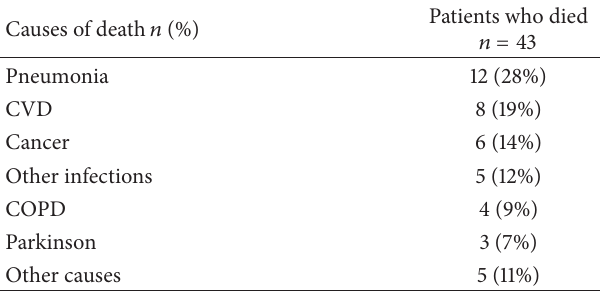
Note . CVD: cardiovascular disease, COPD: chronic obstructive pulmonary